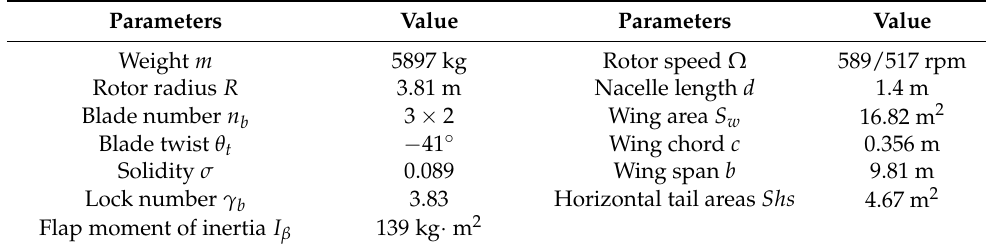
Table 1. Basic parameters of XV-15 tiltrotor aircraft.